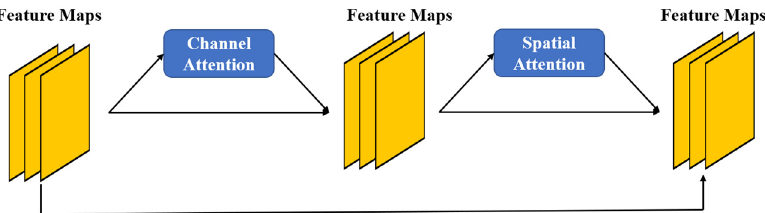
Figure 2. Attention modules with both channel and spatial attention modules similar to [36]. Both attention modules can be added to any location in